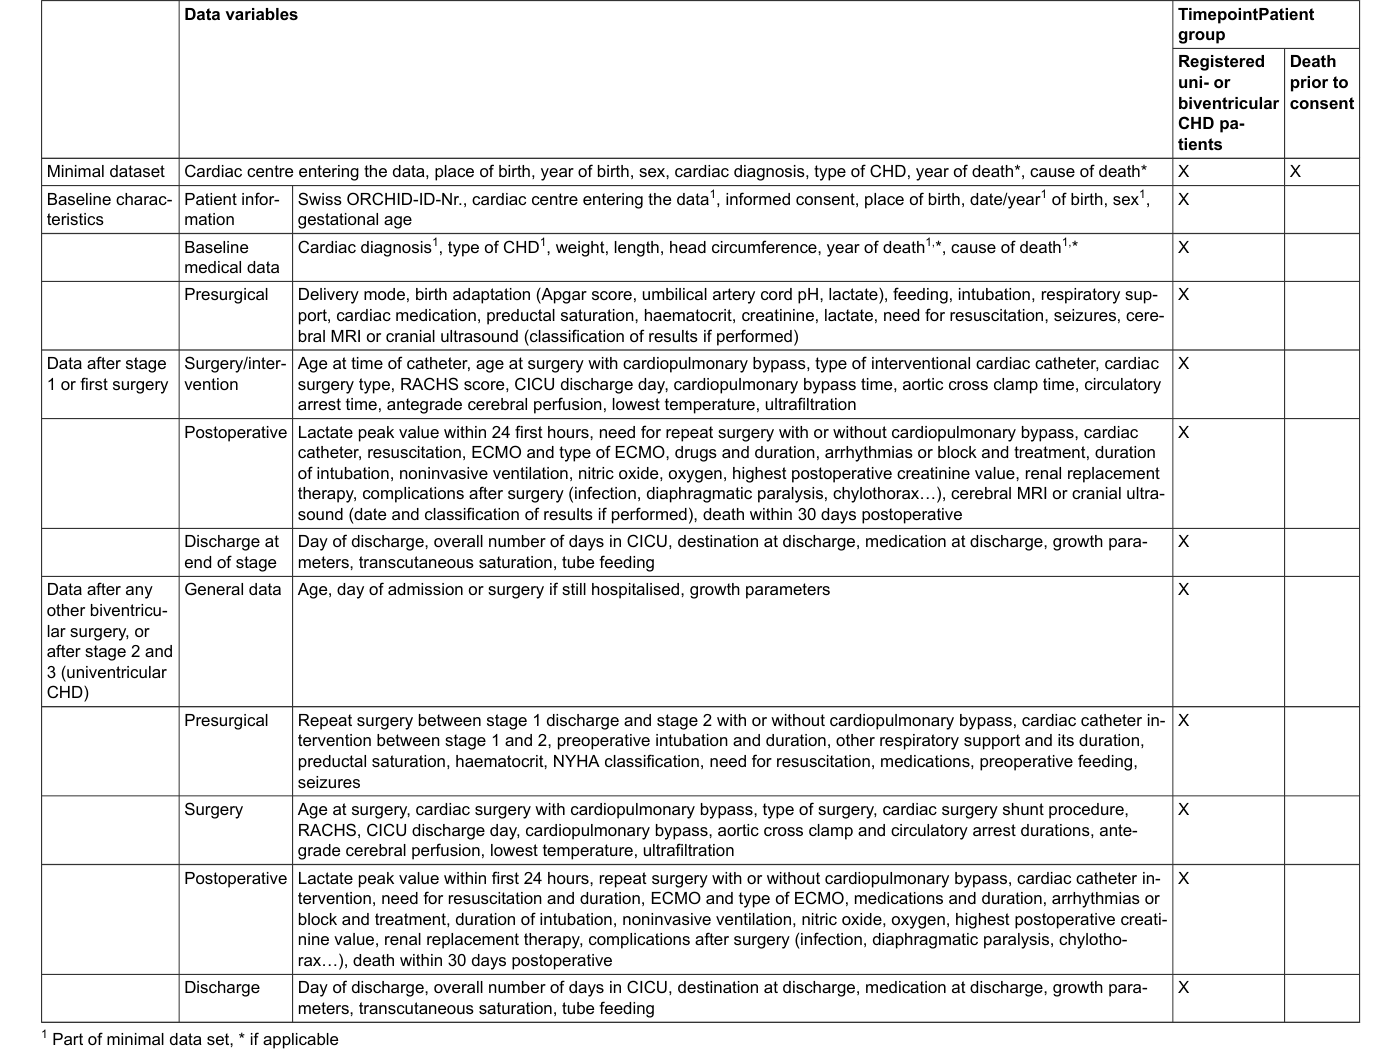
Table 3: Medical and surgical variables of ORCHID.